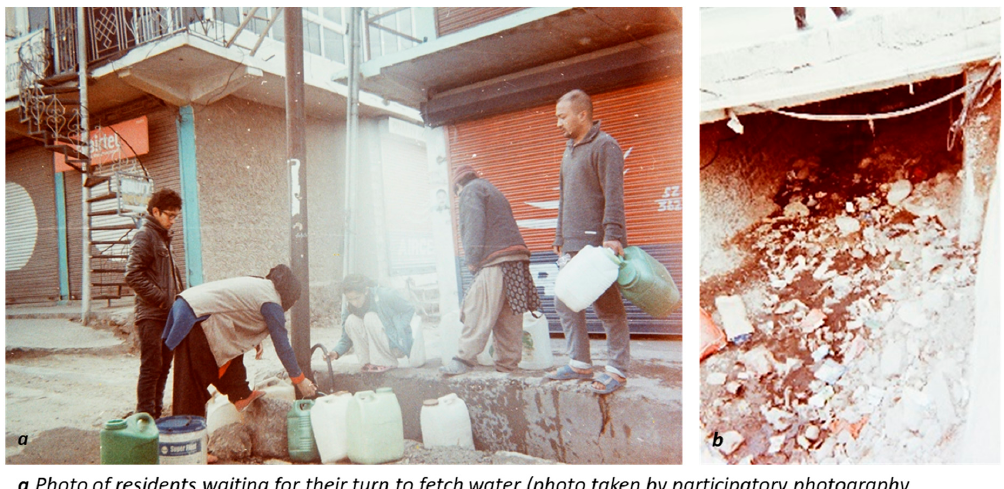
Figure 7. Photographs taken during the participatory photography workshop in 2016.